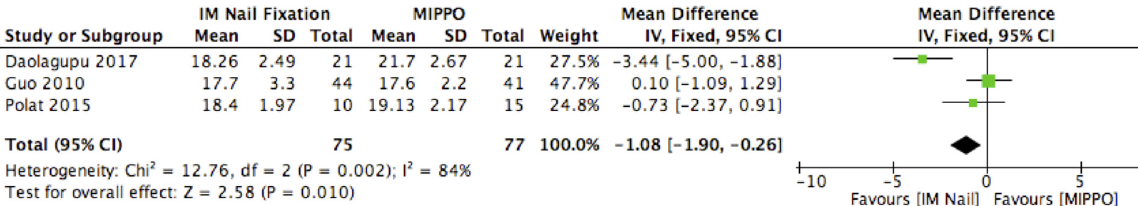
Fig. 4. Time to union.